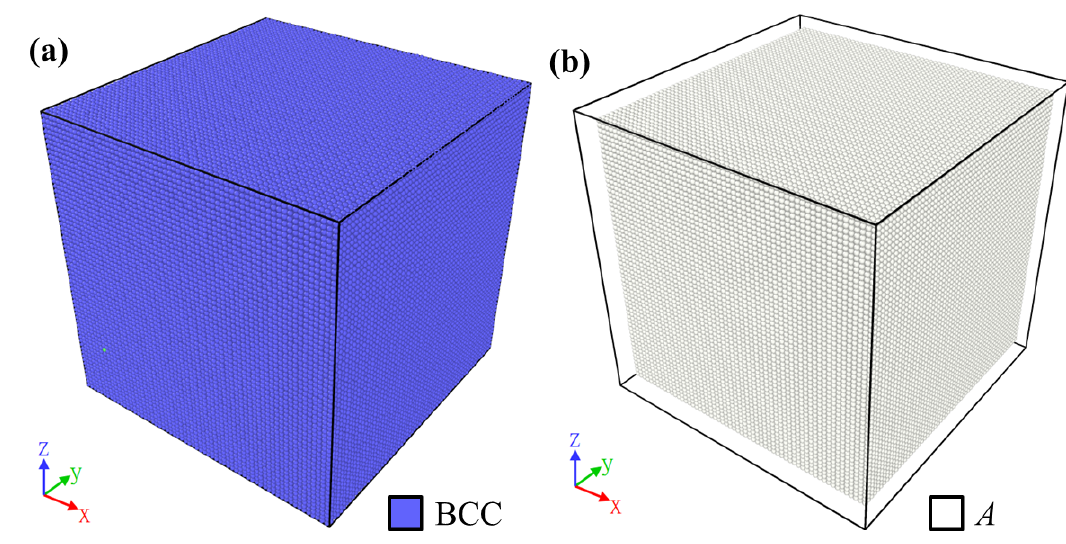
Figure 2. A typical example of the results at the initial step of the compression tests, analyzed and visualized with ( a ) polyhedral template matching (PTM) and ( b ) the martensite variant